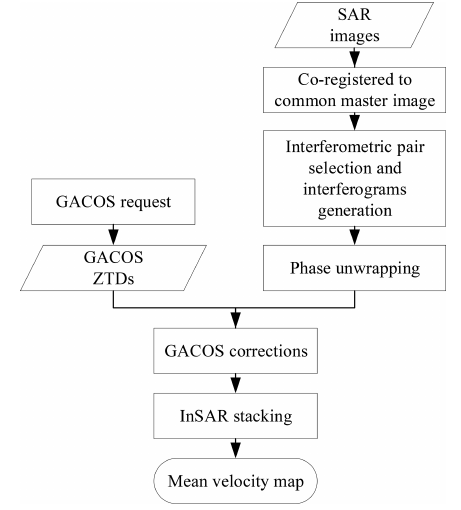
Figure 1. Data processing flowchart of GACOS-corrected InSAR stacking.